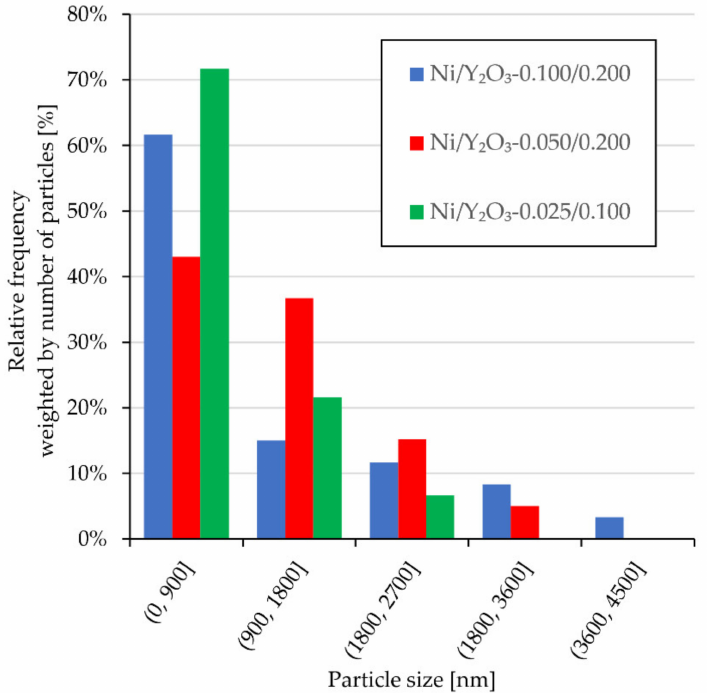
Figure 5. Ni/Y 2 O 3 nanocomposite particle distribution obtained from the SEM micrographs for samples: Ni/Y 2 O 3 -0.100/0.200, Ni/Y 2 O 3 -0.050/0.200, Ni/Y 2 O 3 -0.025/0.100. SEM micrographs 8a–8c show that the Ni/Y 2 O 3 nanocomposite particles are